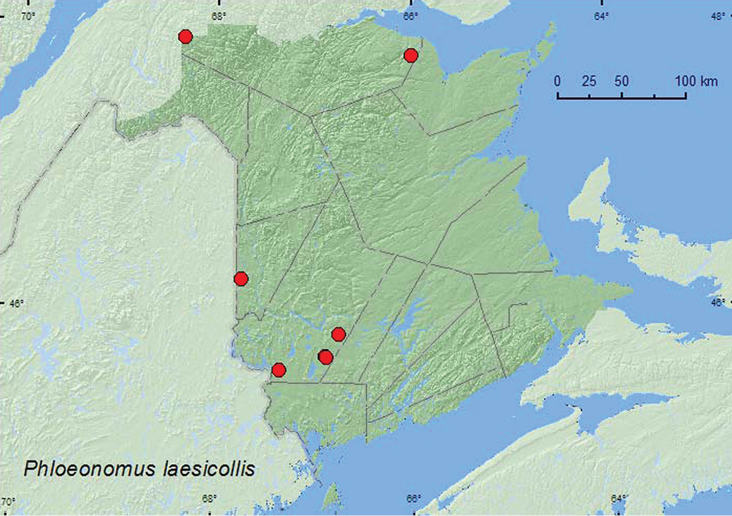
Collection localities in New Brunswick, Canada of Phloeonomus laesicollis.